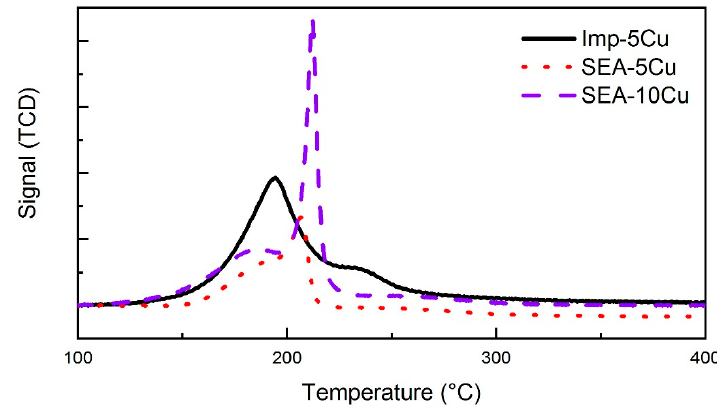
Figure 1. H 2 -TPR profiles of samples prepared by the Imp or SEA method with different